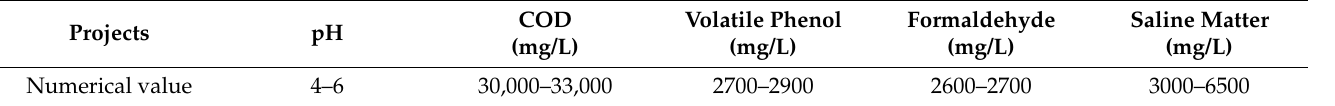
Table 1. Main quality indexes of resin